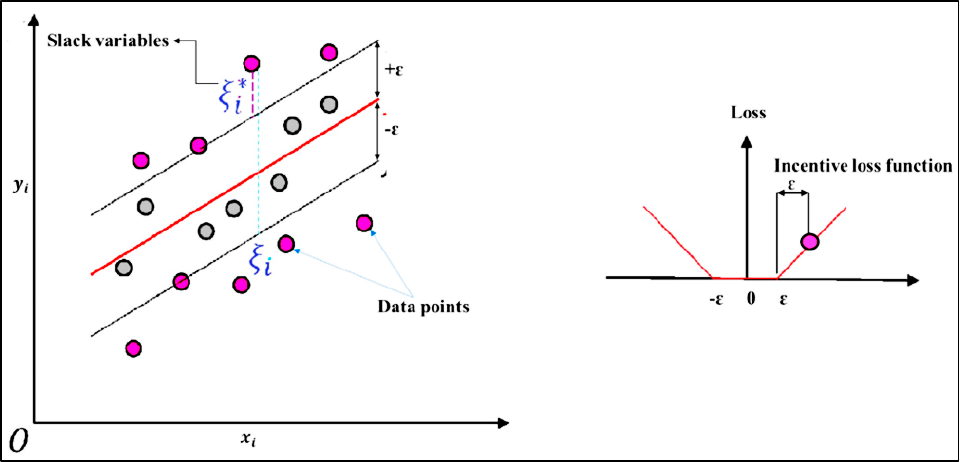
Figure 3. Graphic schematic layout of the support vector machine.